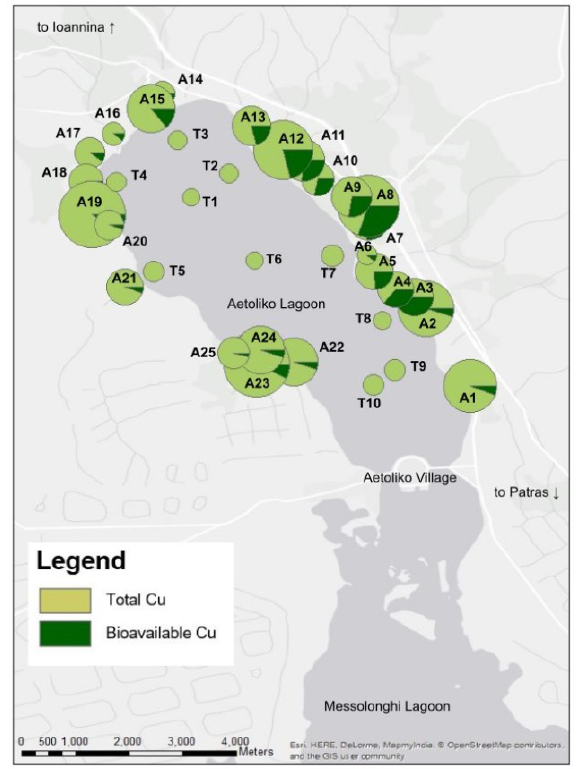
Figure 4. Total and bioavailable copper concentration.